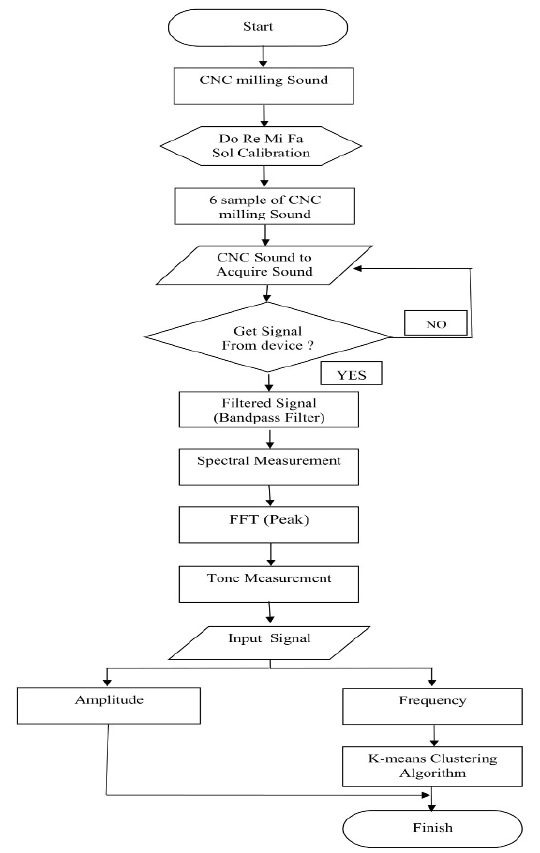
Figure 3. Flowchart diagram.